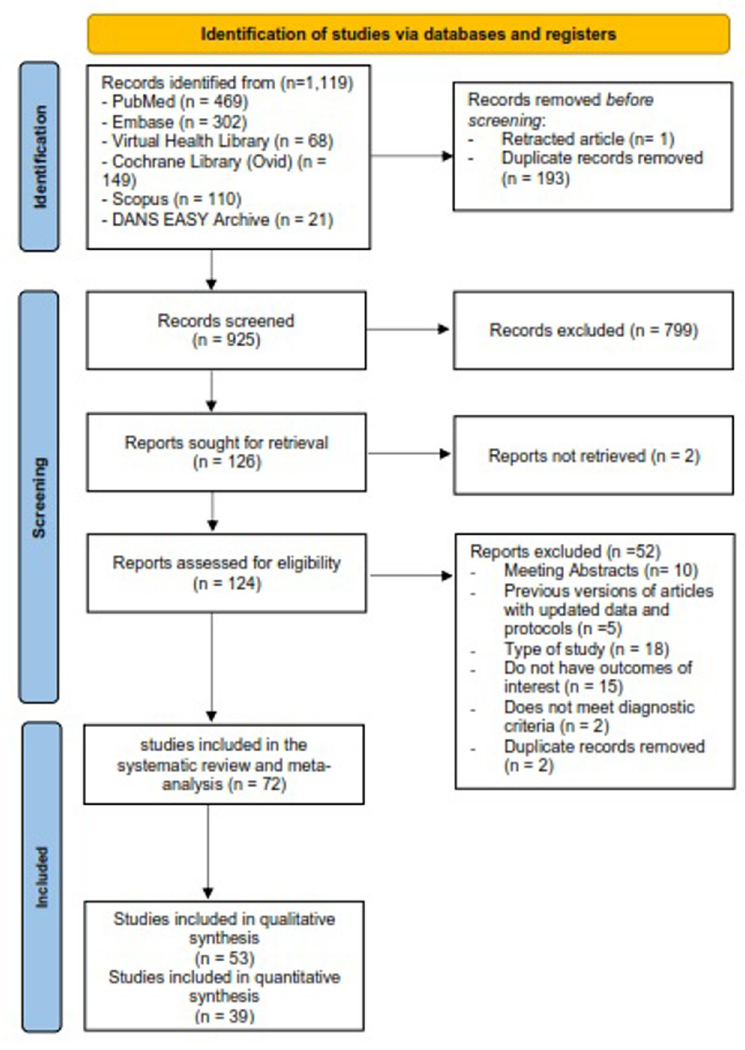
Fig 1. PRISMA flow diagram for selected studies included in the systematic review and